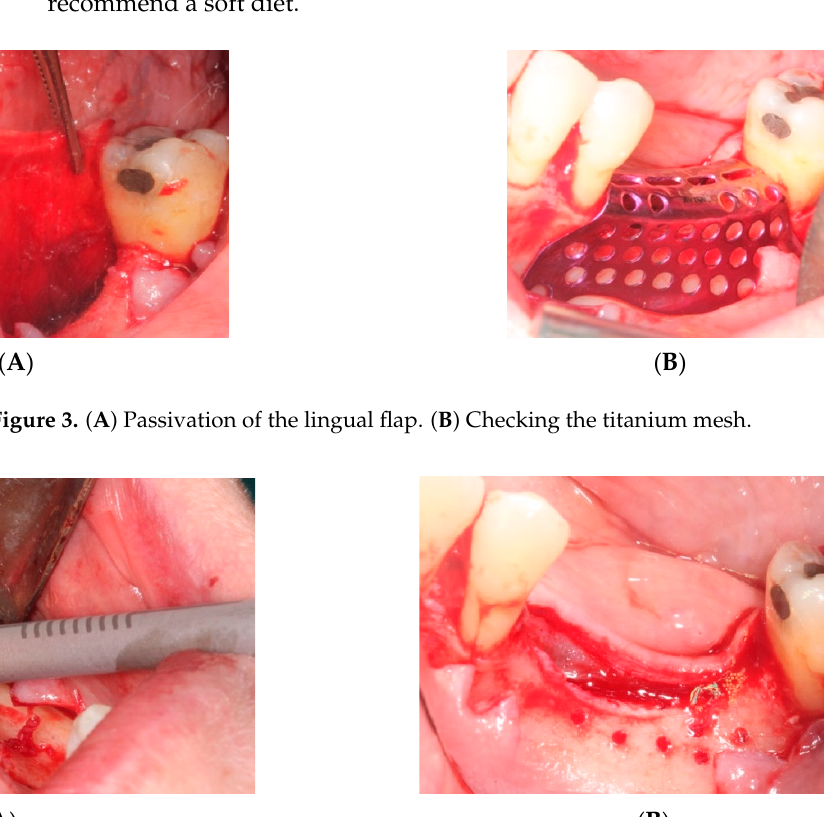
Figure 3. ( A ) Passivation of the lingual flap. ( B ) Checking the titanium mesh.